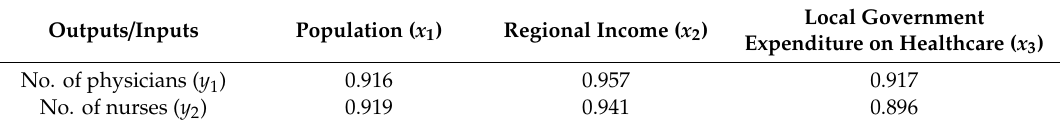
Table 2. The correlation coe ffi cient between input and output